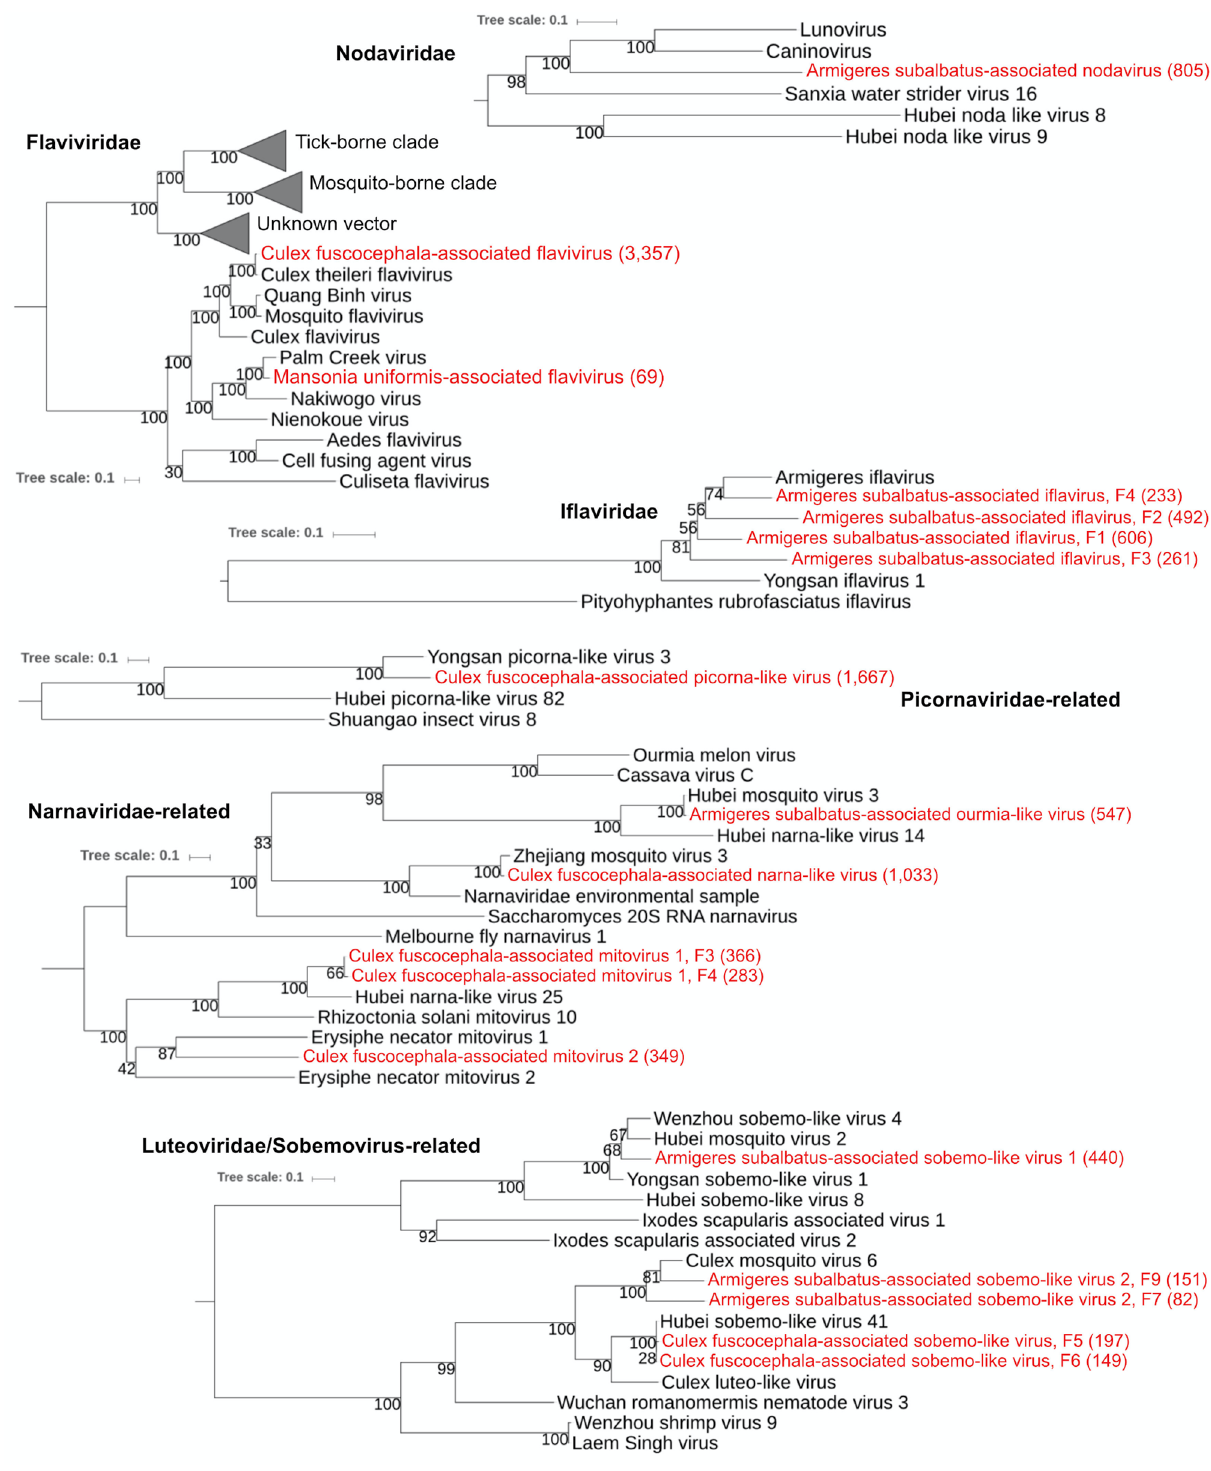
Figure 4. Phylogenetic relationships of the positive sense ssRNA viruses discovered in this study (labeled red) and other known viruses. The analyses were based on RNA-dependent RNA polymerase (RdRp) amino acid sequences, except for Flaviviridae and Iflaviridae trees, in which polyproteins were used. The numbers in parentheses are the lengths of the amino acid